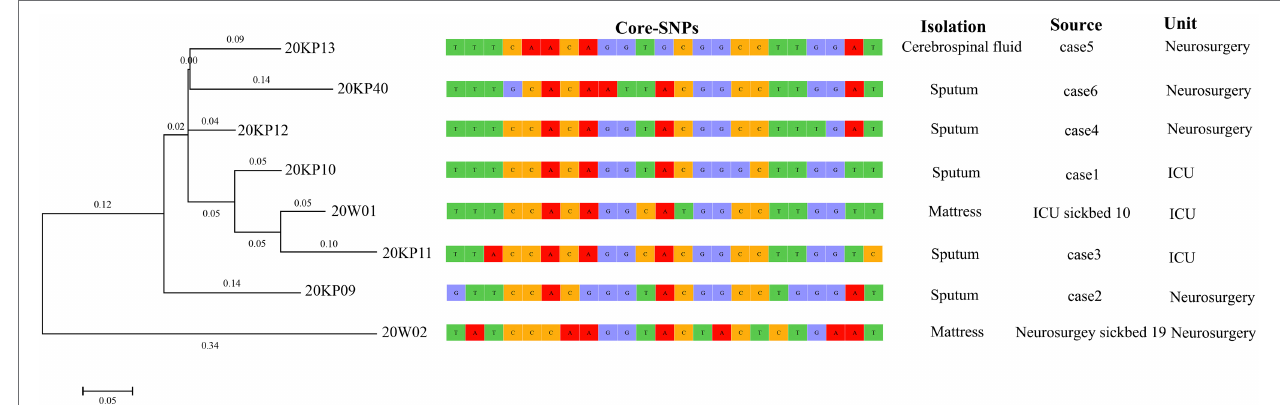
FIGURE 4 | Phylogenetic tree of eight XDRKp strains based on core single-nucleotide polymorphisms.